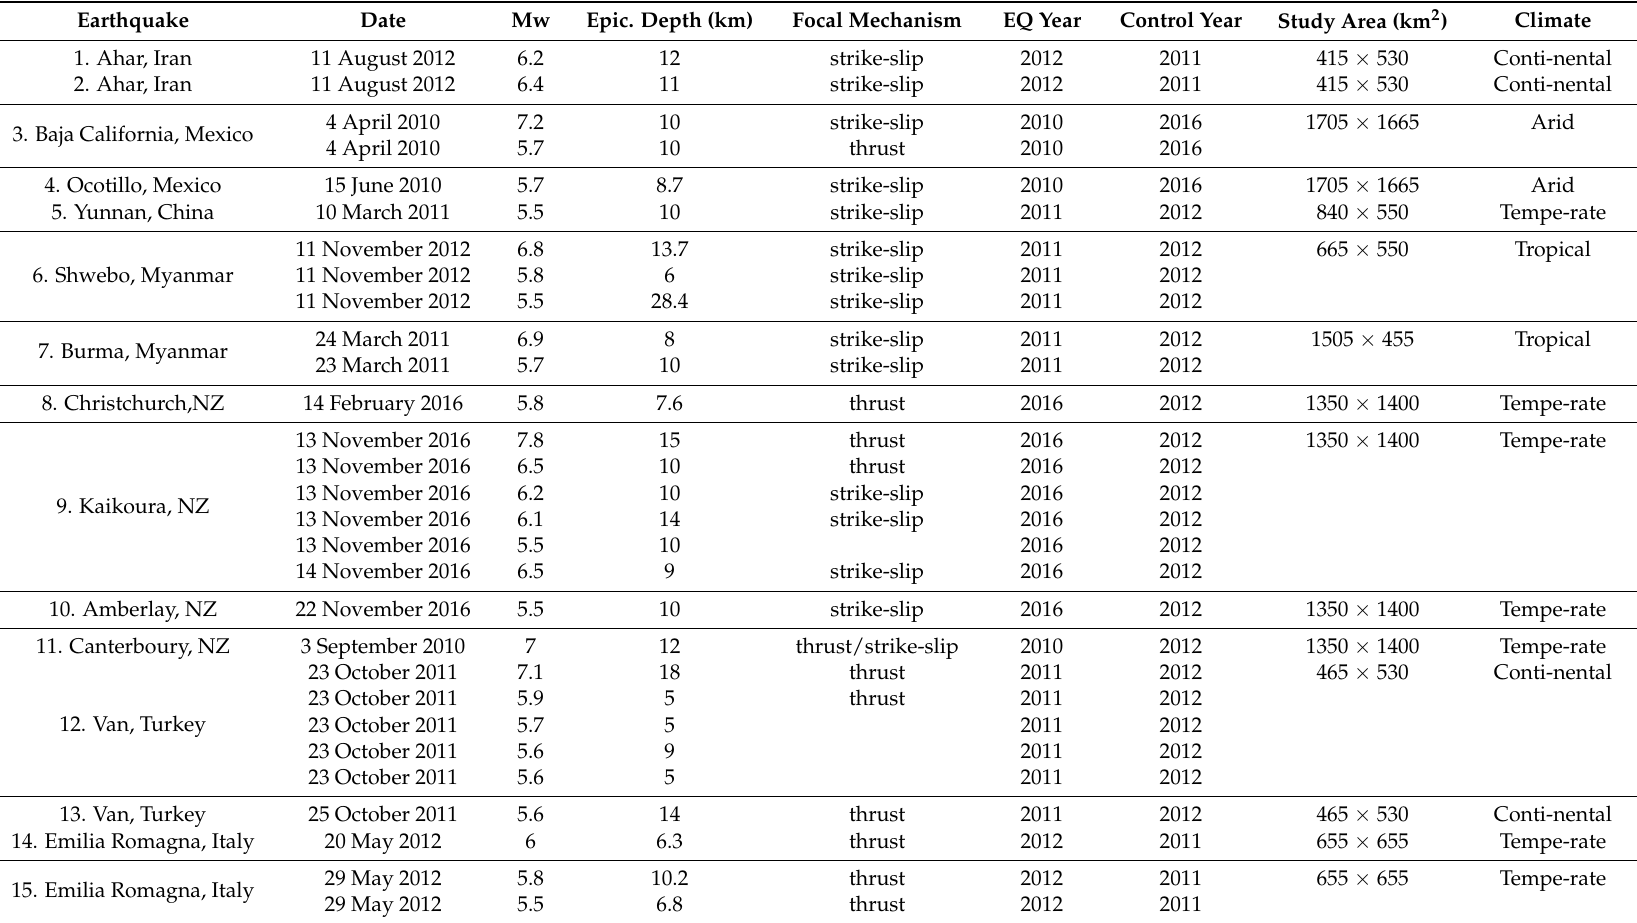
Table 1. Earthquake events studied in this work and corresponding study areas. The spatial extent is given in km 2 based on the nominal spatial resolution of the LST dataset. Earthquakes occurring within 24 h are grouped together. The climate classification is based on Peel et al. [39]. The earthquake information is taken from the online earthquake catalogue of USGS